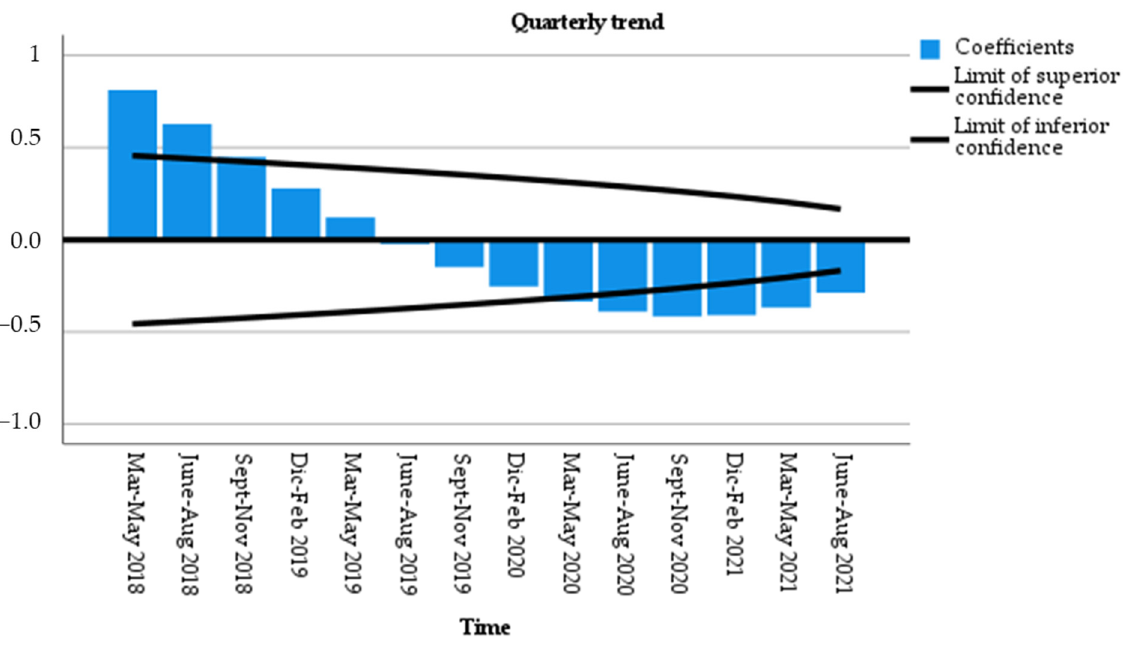
Figure 3. Autocorrelation function (ACF) and partial autocorrelation plots: seasonal differencing of quarters from March 2018 to August 2021.